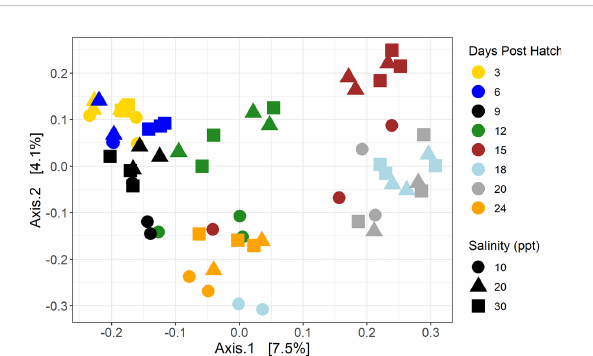
FIGURE 5 Boxplots summarizing Shannon diversity in larvae samples by days post hatch. Bars denote largest and smallest values within 1.5 times the interquartile range with dots representing values outside that range, middle line is the medium, and ends of boxes are the fi rst and third quartiles. Letters above the boxplots indicate results of pairwise